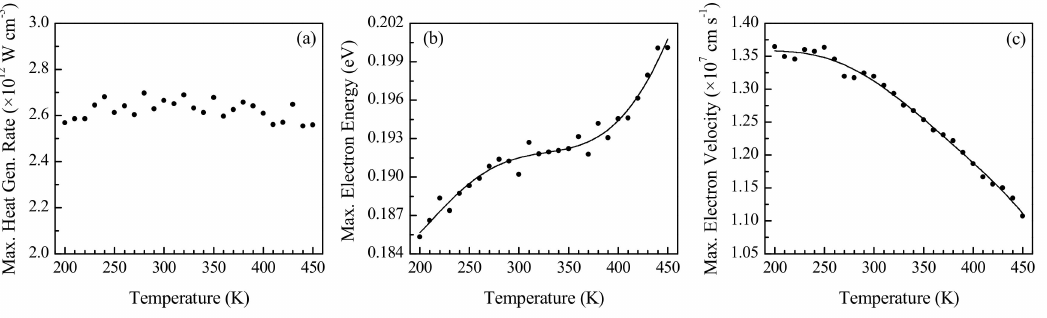
Figure 9. E ff ect of initial temperature on the maximum ( a ) volumetric heat generation rate, ( b ) electron energy and ( c ) electron drift velocity in a 10 nm channel n + nn +